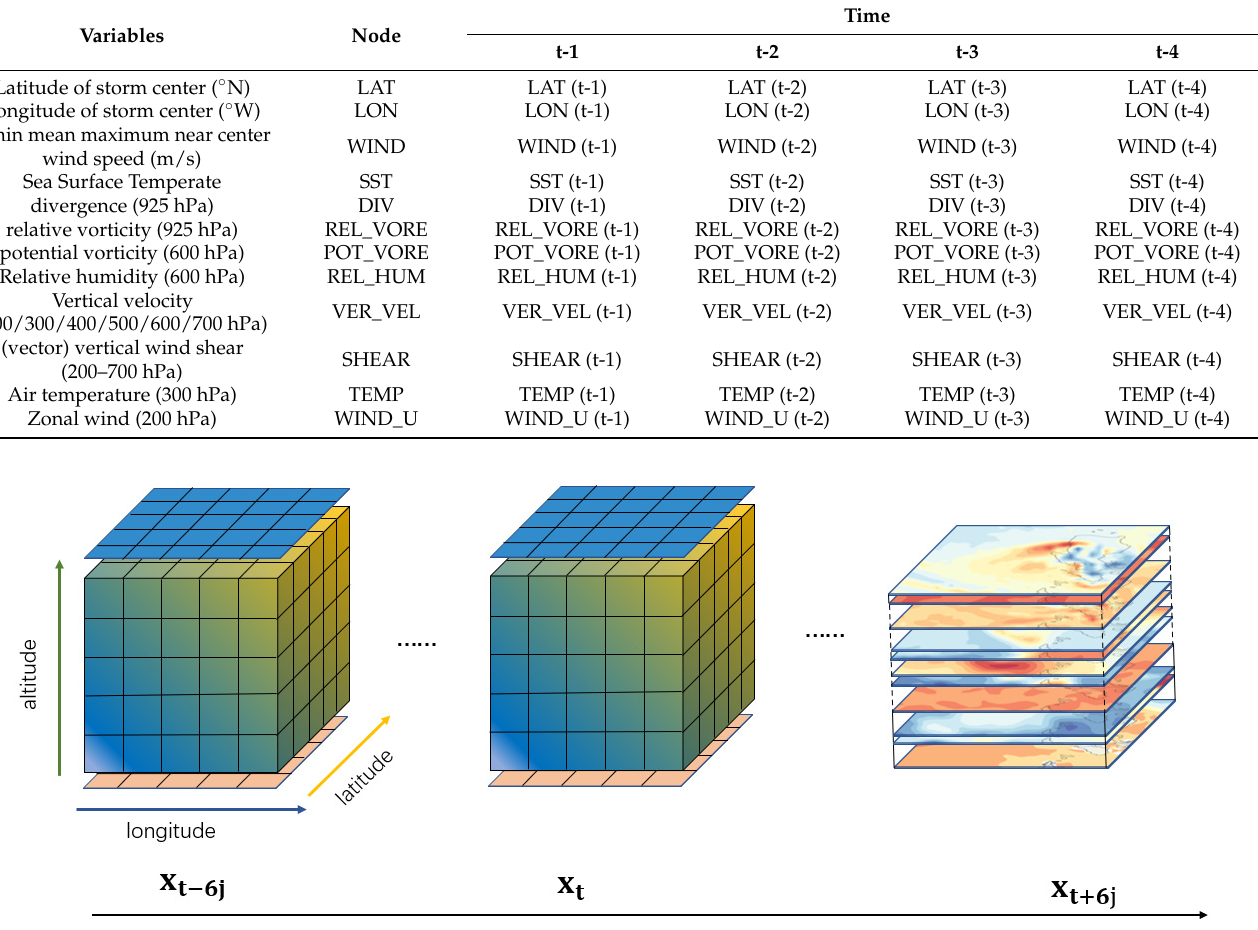
Figure 2. Structure of the spatio-temporal environment field. From top to bottom: 2D atmospheric data, 3D atmospheric data, 2D ocean data.